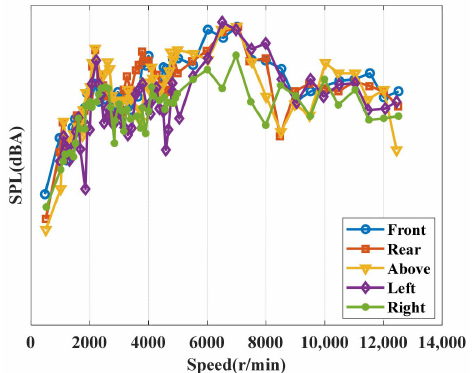
Figure 6. Simulation results of five microphones at a distance of 1